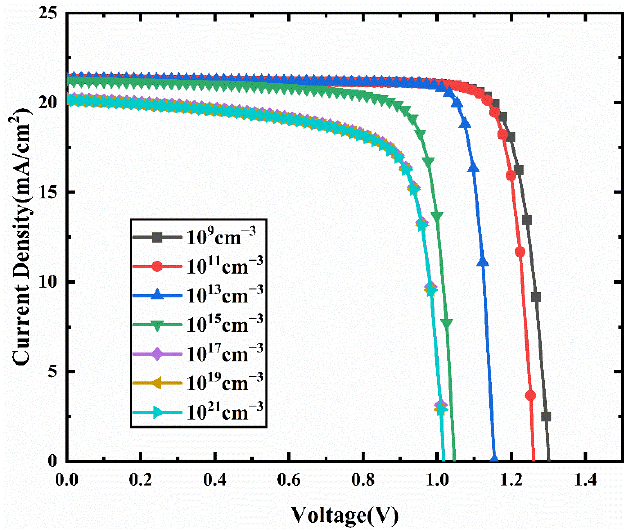
Figure 15. Comparison of J-V characteristic curves for different CCSCNCs/TiO 2 interface layer defect density.